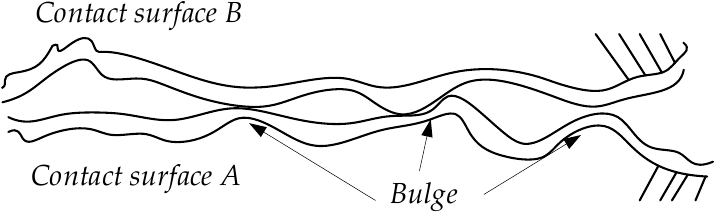
Figure 1. Microgram of contact surface sketch.